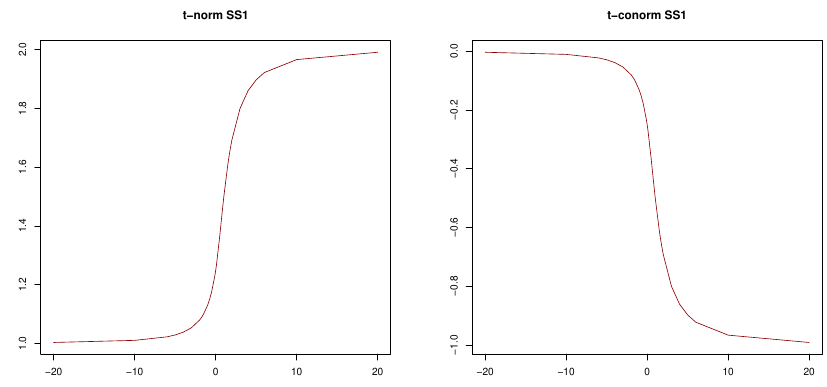
Figure 2. Andness of t-norm T SS 1 ( left ) and t-conorm S SS 1 ( right ) given its parameter p